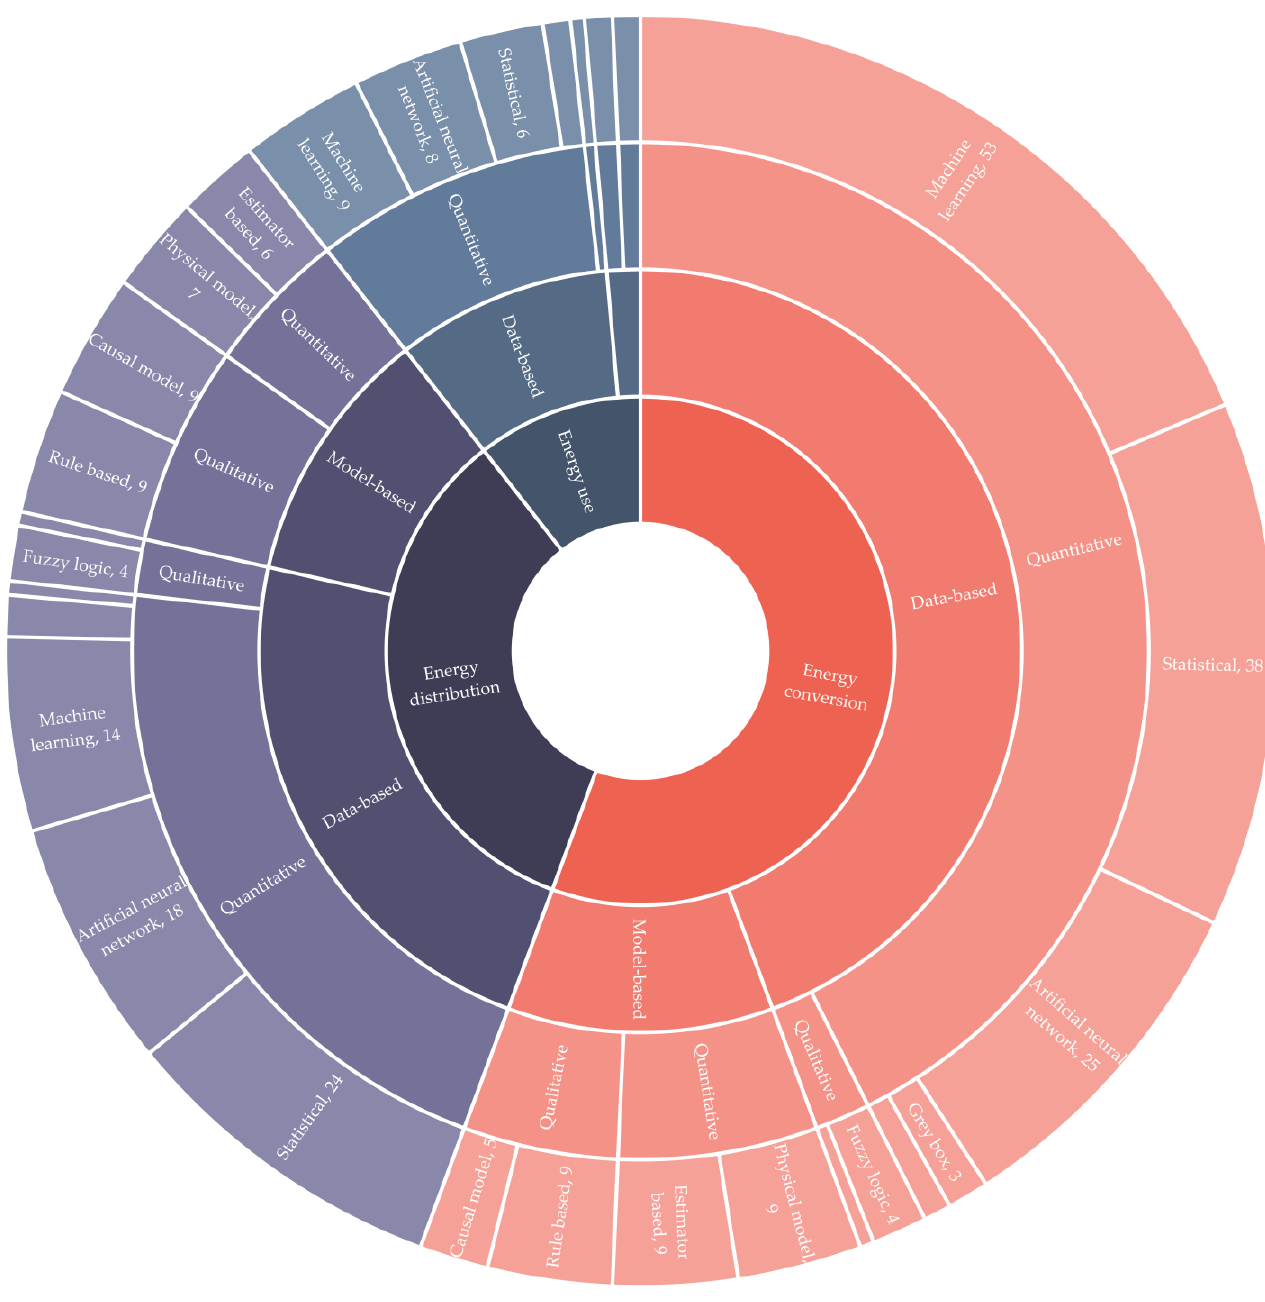
Figure 11. Articles categorized according to EST group and modeling approach.